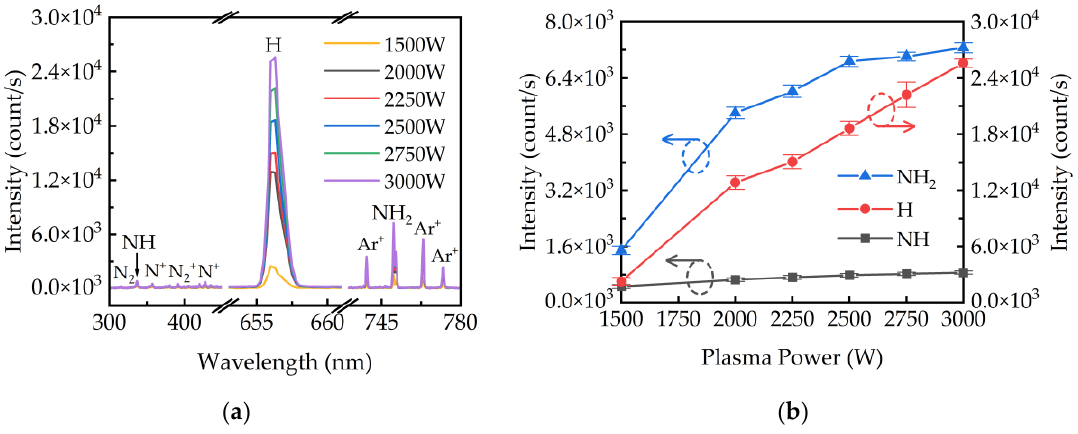
Figure 1. ( a ) The plasma emission spectra obtained at various plasma powers. ( b ) The plot of emission intensity of H, NH, and NH 2 radicals as a function of plasma powers.